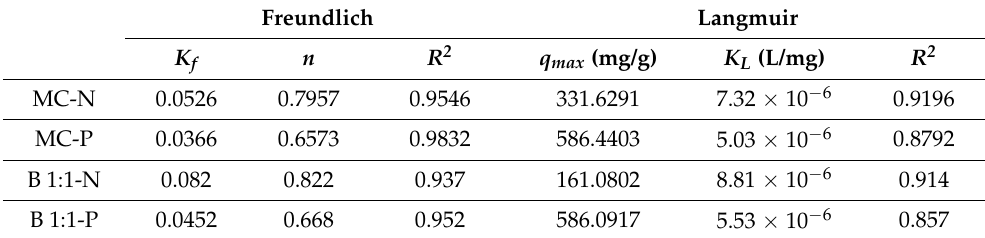
Figure 6. Fit to isothermal non-linear models of the adsorption equilibrium experimental data of ( a ) nitrate and ( b ) phosphate using biochar (B 1:1) as adsorbent. Table 2. Adjustment parameters of NO 3 − and PO 43 − non-linear adsorption